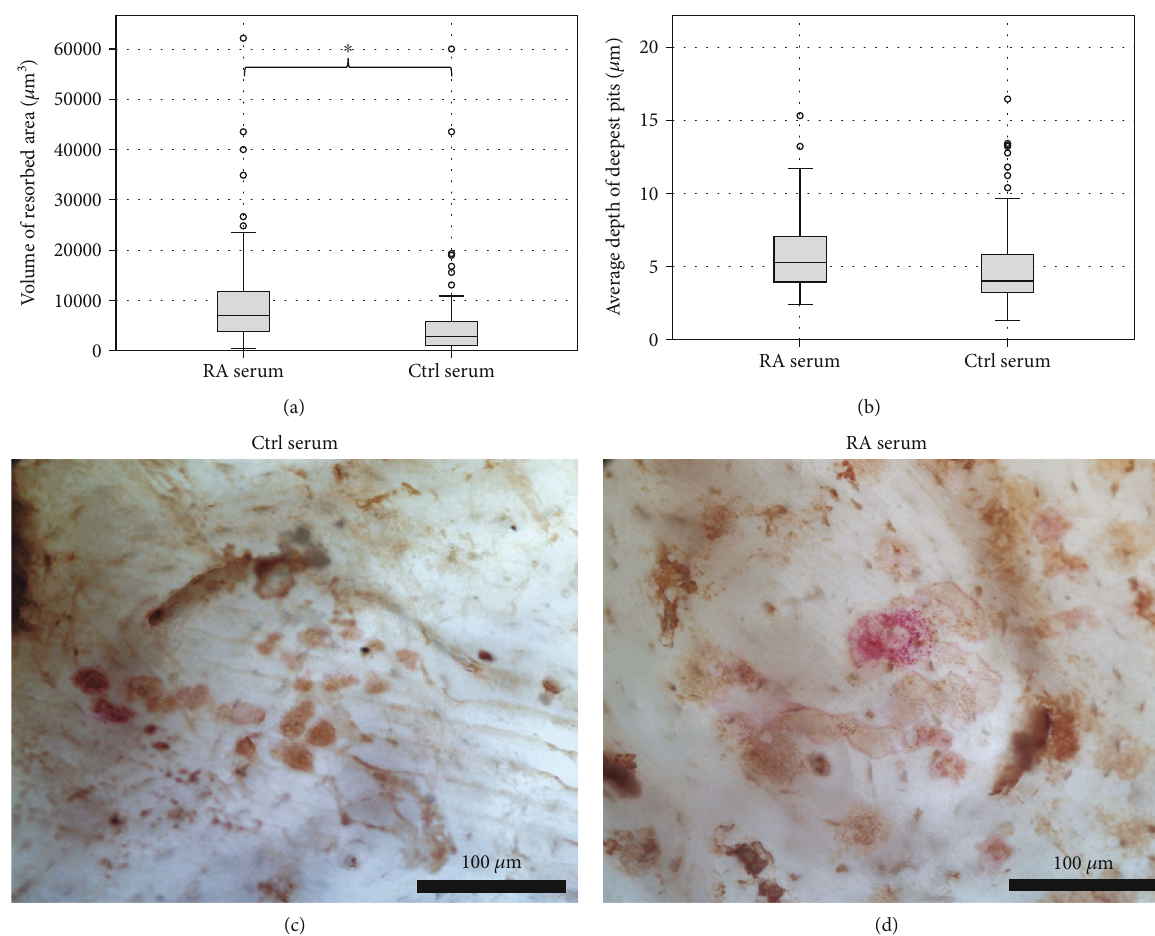
Figure 5: Bone resorption in cultures with RA and healthy serum. Panel (a) shows the average resorbed bone volume measured with a laser microscope from the serum experiment. Panel (b) shows the average depth of the deepest pits on the bone slices. Panels (c) and (d) show examples of WGA-lectin-stained resorption pits (brown color) on the bone slices. 40x magni fi cation. In image (c), there is a single TRAcP positive cell remaining attached to the bone after the mechanical removal of cells by